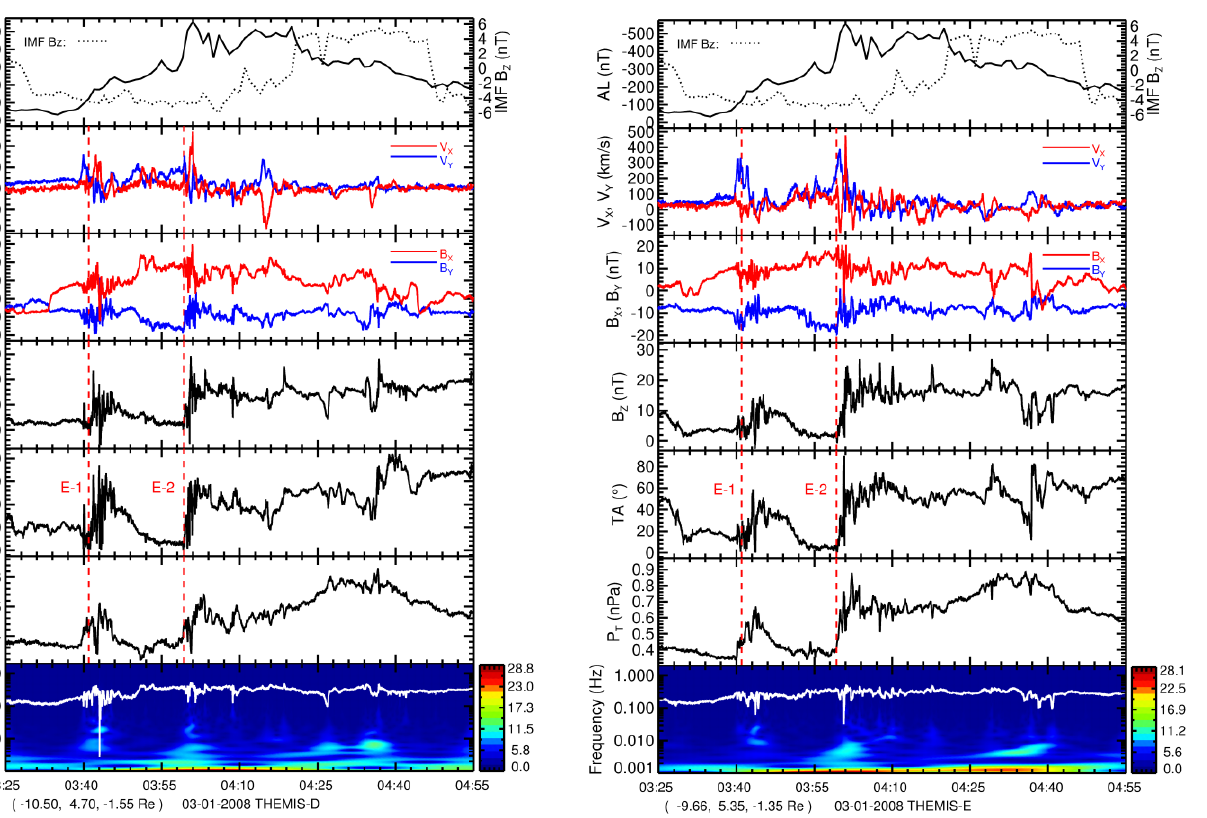
Fig. 1b. Summary plot of TH-E observations at ( − 9.66, 5.35, − 1.35 Re ) in the same format as in (a) . Comparisons between TH- D and TH-E data are discussed in Sect.